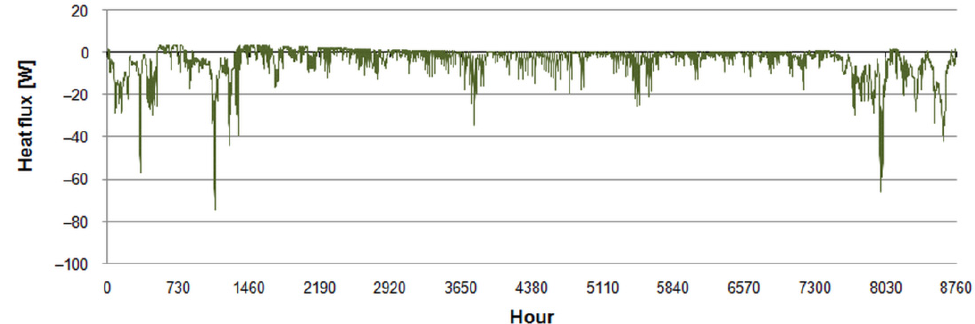
Figure 14. Hourly differences of calculated heat flux from EAHE between methods 1 and 3.